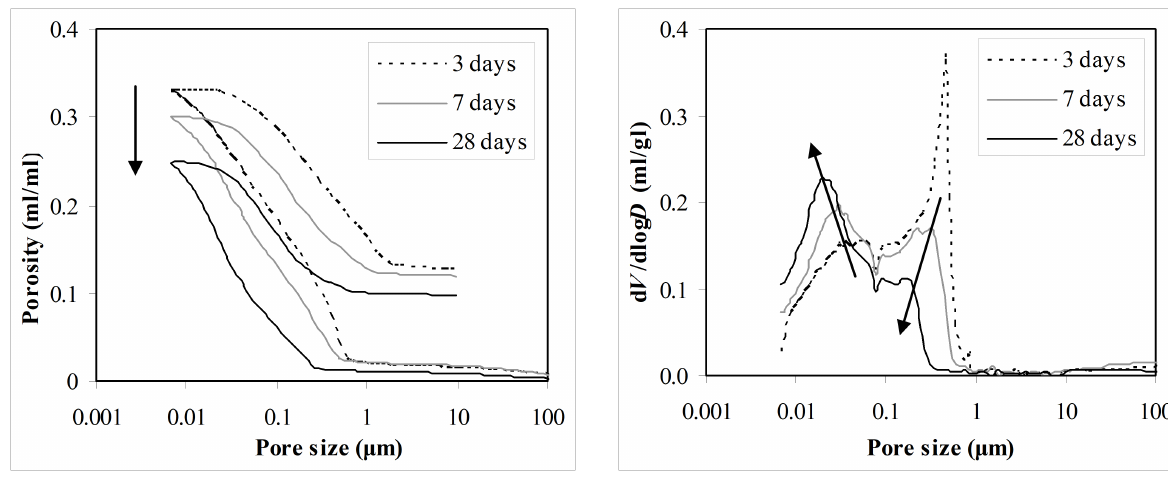
Figure 4: Porosity and pore size distribution of ASTM type I cement paste by MIP